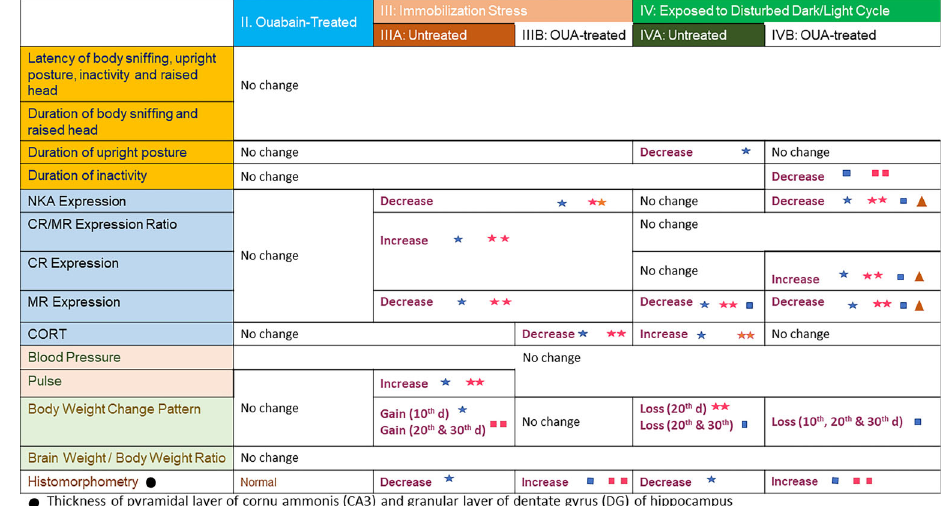
Figure 11. Descriptive results of behavioral, biochemical, cardiovascular, percent changes in body weight, brain-to-body weight ratio, and histomorphometry results of studied adult male Wistar albino rats (7 – 8 months of age), subdivided into four main groups: I: Control; II: Ouabain (OUA)-treated; III: Immobilization; and IV: Disturbed dark/light cycle. Both stress models (III and IV) were further subdivided into A: Untreated and B: Ouabain-treated. Signi fi cance: Blue star: P o 0.05 compared to control group; Double pink stars: compared to OUA-treated control group; Blue square: P o 0.05 compared to untreated immobilized rats; Double pink squares: P o 0.05 compared to untreated disturbed dark/light cycle; Orange triangle: P o 0.05 compared to ouabain-treated immobilized rats.